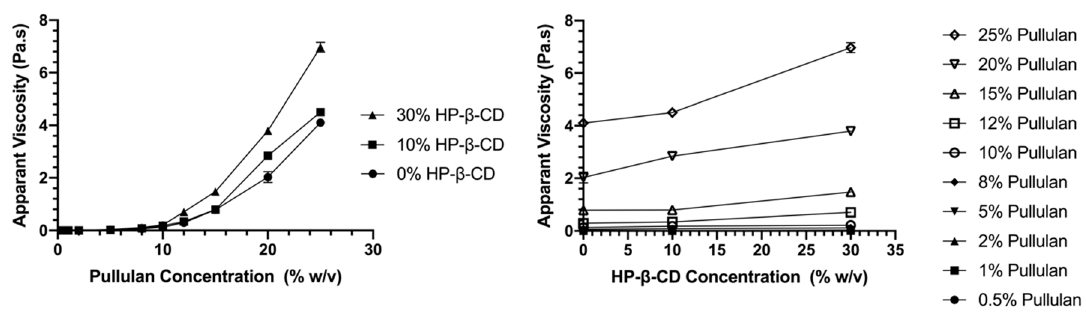
Figure 7. Plot of apparent viscosity (at shear rate of 100 s-1) versus ( a ) pullulan concentration (% w/v) and ( b ) HP- β -CD concentration (%